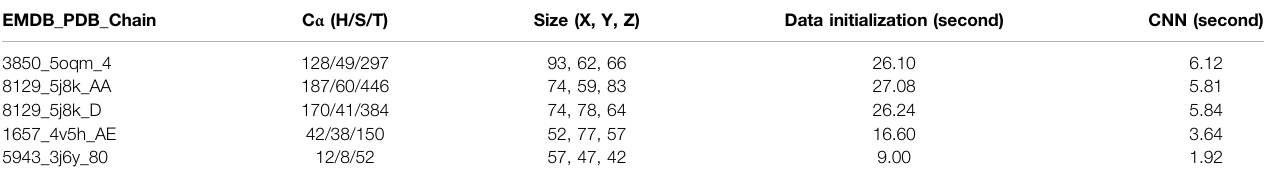
TABLE 1 | Run time of DeepSSETracer 0.1 on a Linux System. From left to right: EMDB ID, PDB ID, chain ID, the number of C α atoms in the chain for H: helix, S: β -sheet, T: entire chain, the number of voxels in each of the X, Y, Z dimensions, the time to load and initialize data, and the time for CNN network to produce the results using one CPU and one GPU on a Linux